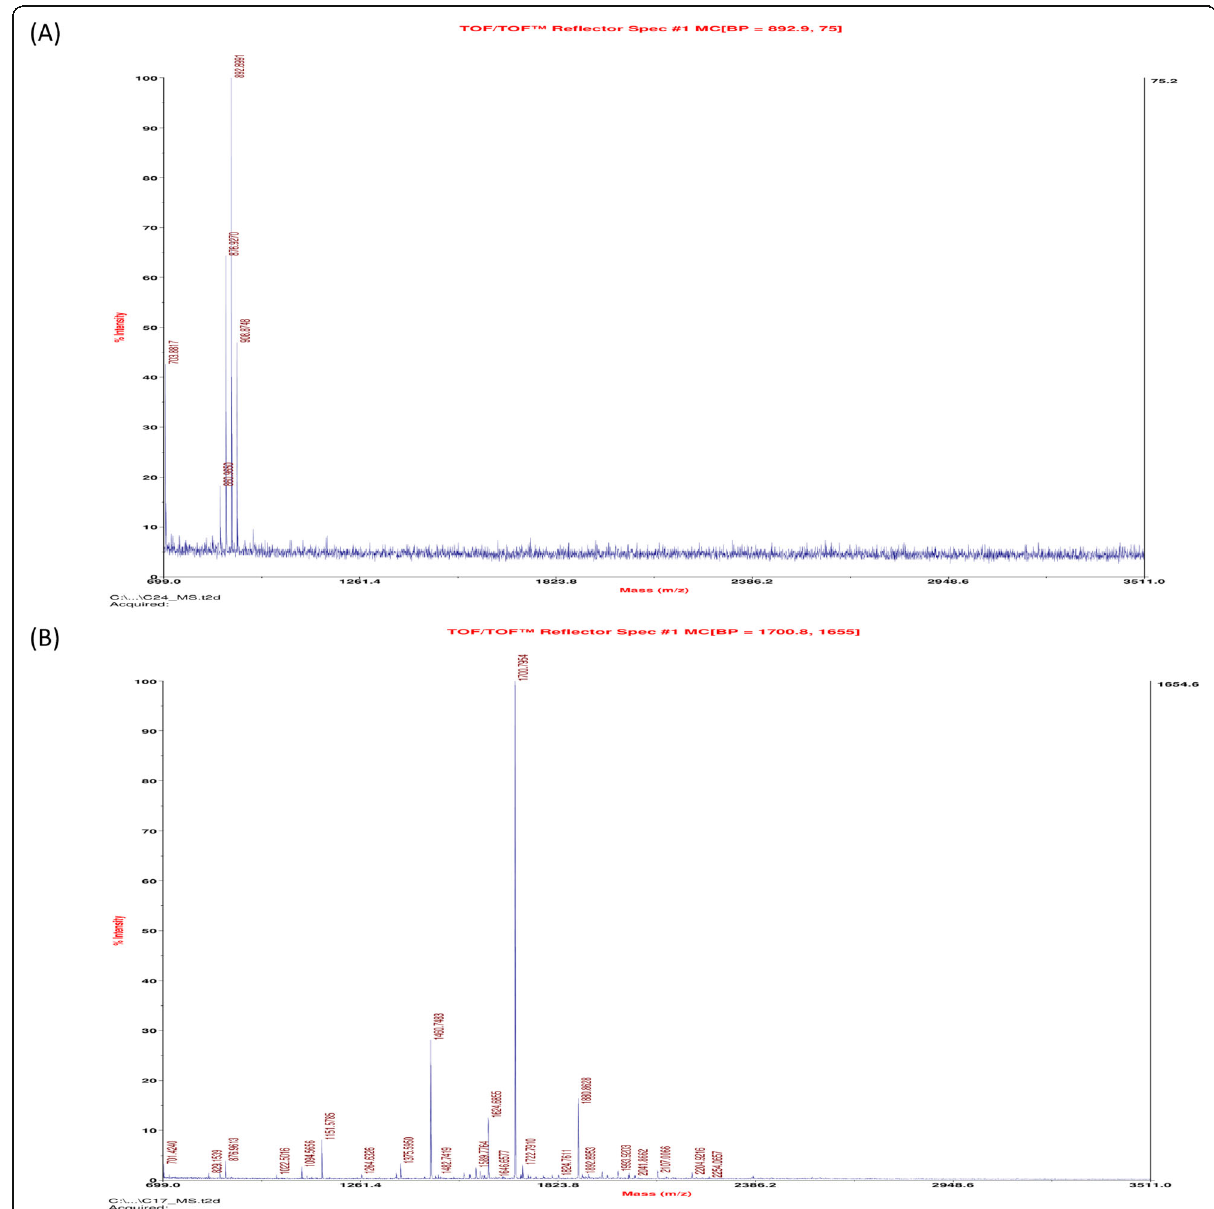
Fig. 5 Mass Spectrum of soy peptide from soy milk fermented with: a M2 and b